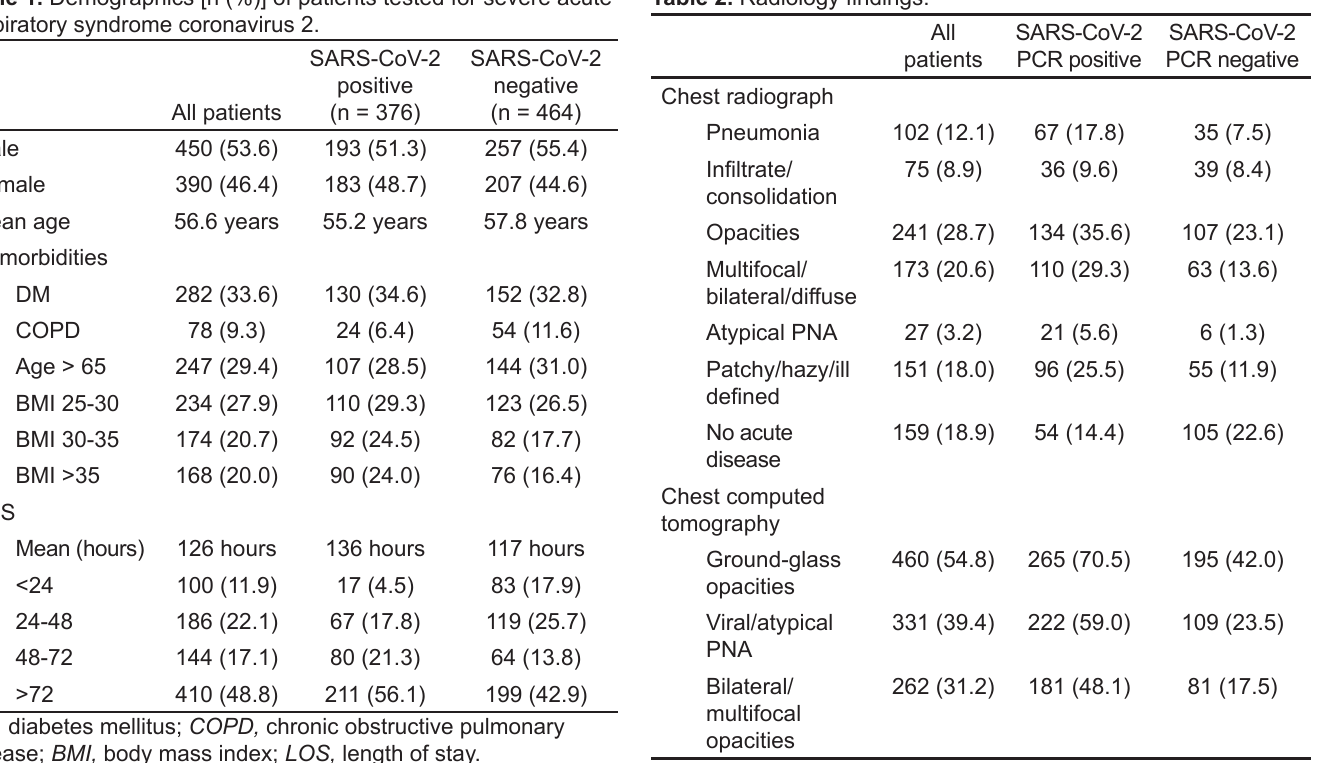
Table 2. Radiology findings.